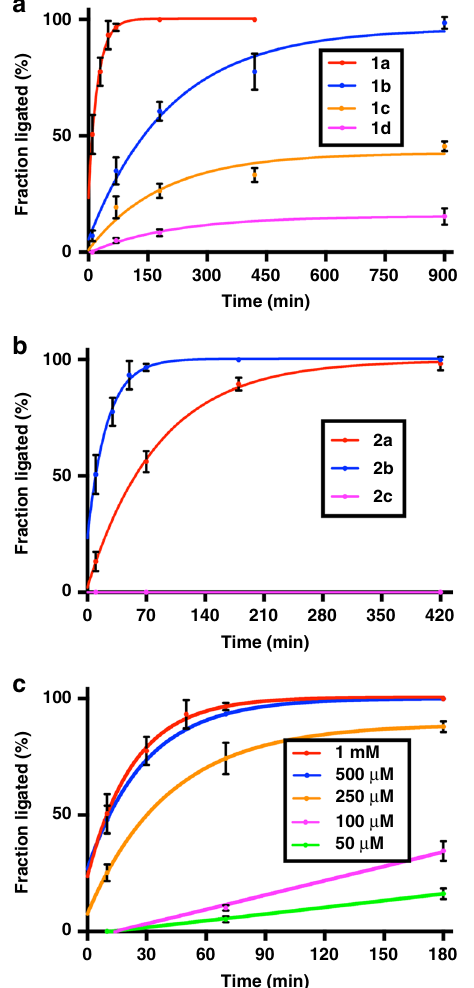
Fig. 2 Kinetic measurements of NCL between LYRMG-Z (1a – d) and CDap (PhCn)ANK (2a – c). a NCL reaction between 1a – d (1 mM) and 2b (1 mM). b NCL reaction between 1a (1 mM) and 2a – c (1 mM). c NCL reaction between 1a (1 mM – 50 µ M) and 2b (1 mM – 50 µ M). Peptides were ligated at room temperature and pH 7.0 in the presence of TCEP·HCl (10 mM).